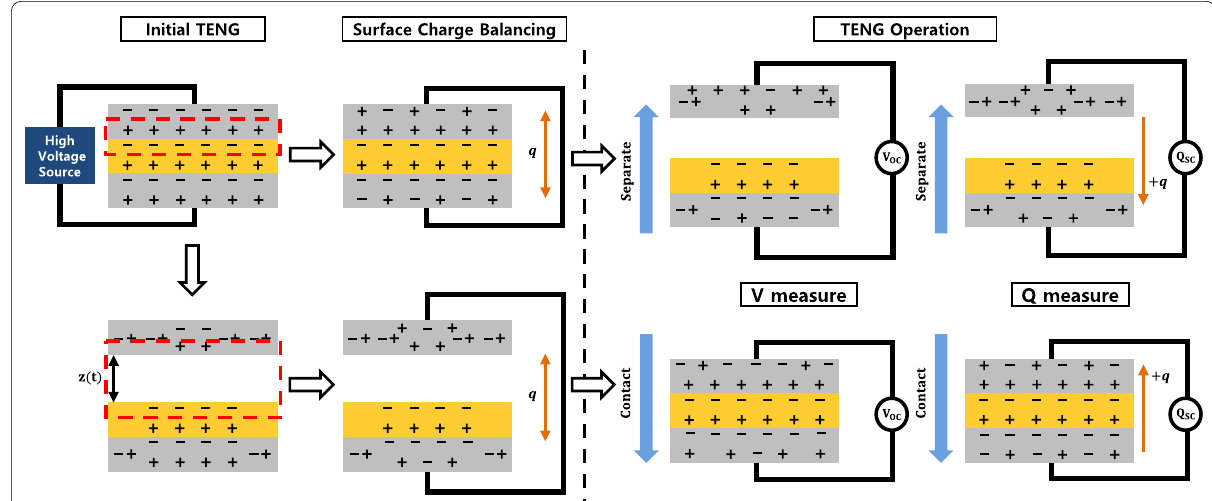
Fig. 4 Schematic diagram of electric charges movement between the metal electrodes under the different charge balancing conditions in the same TENG